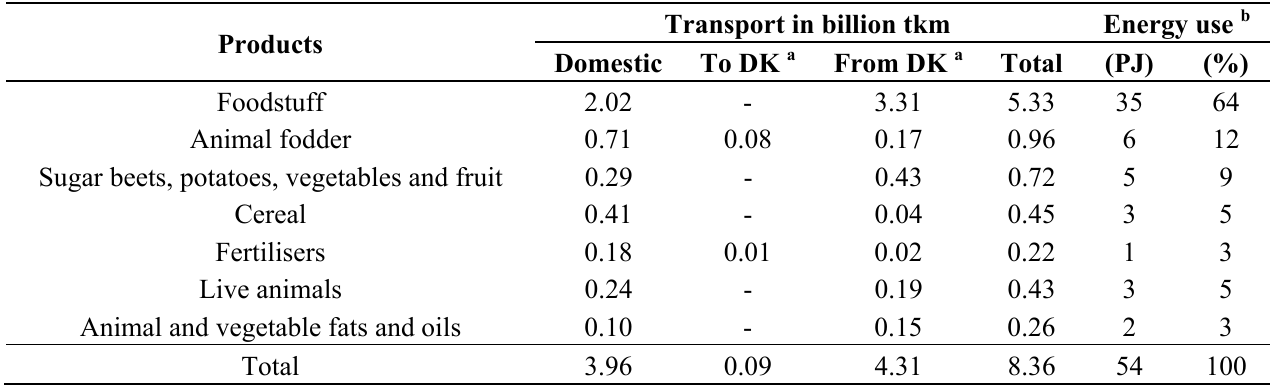
Table 3. Domestic road transport and road transport to and from Denmark of food and agricultural products in billion tonne-kilometres (tkm) and direct and indirect fossil energy